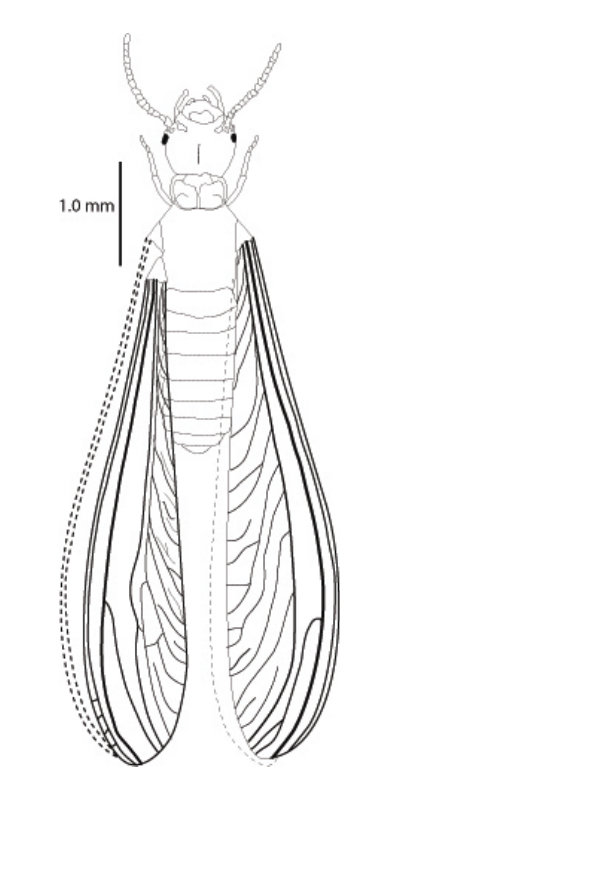
Figure 9. Habitus drawing of R. nelsonae alate, showing fore- and hind wing along with wing venation. Scale bar is 1.0